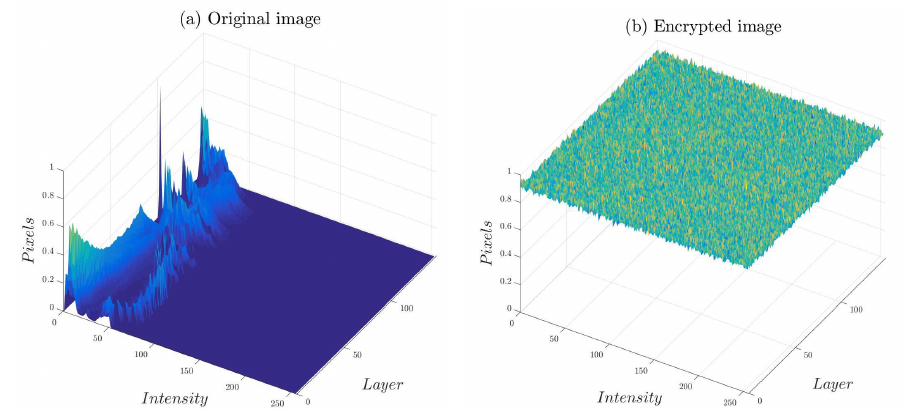
Figure 6. Experiment 1. Hyperhistogram of original an encrypted images.